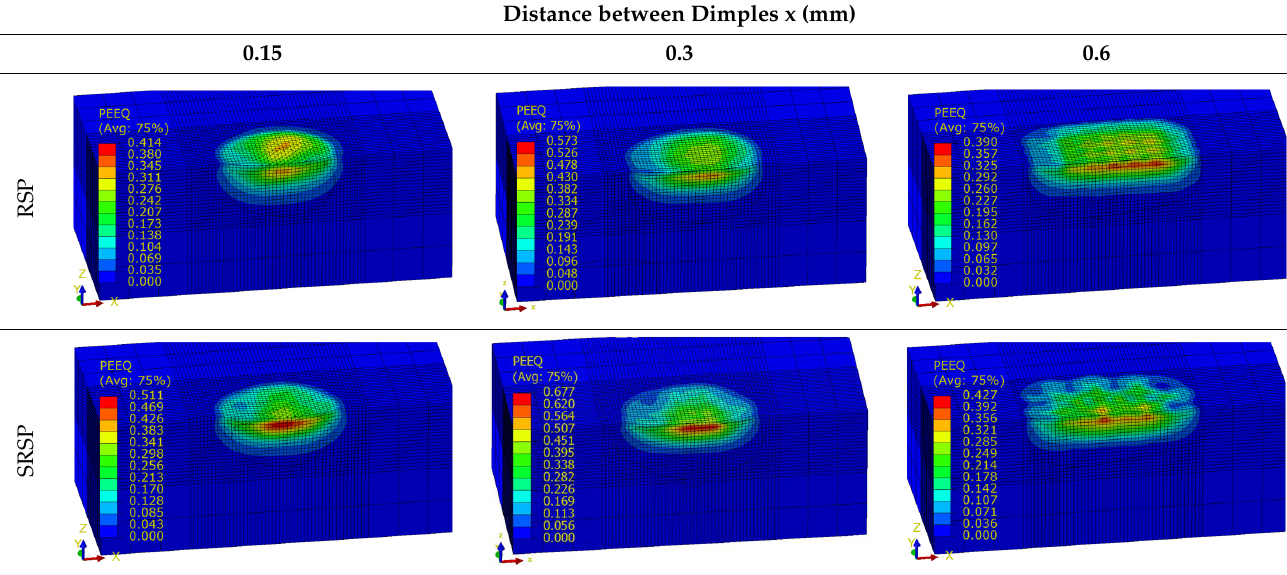
Table 10. Effect of the peening element diameter on the PEEQ equivalent plastic strain after 36 impacts (impact energy E = 100 mJ, distance between dimples x = 0.3 mm).